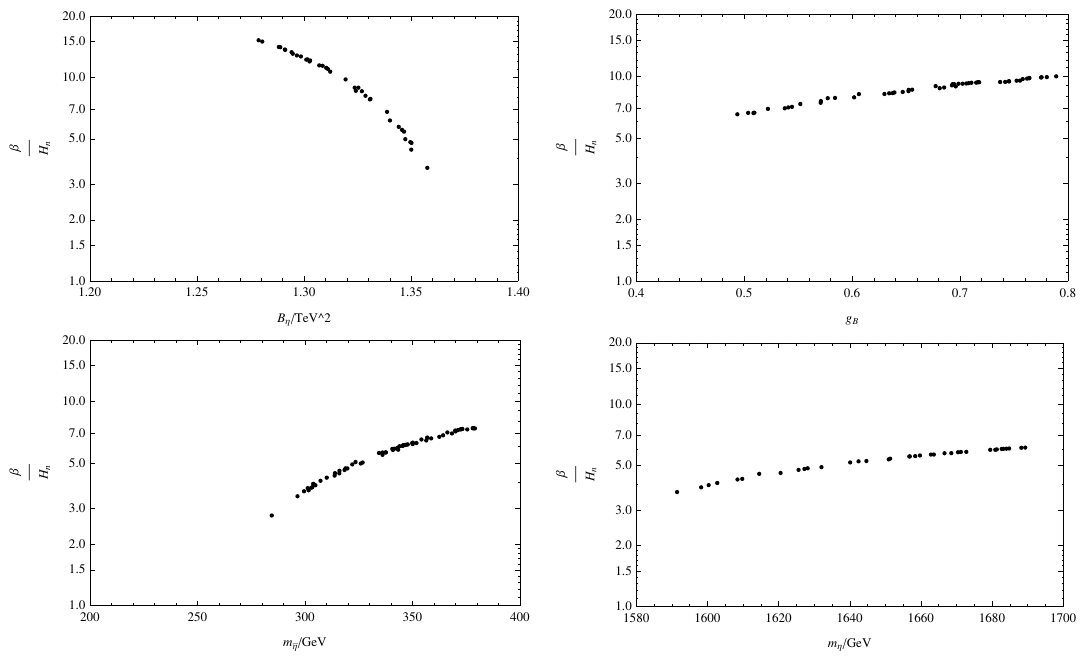
Figure 4 . The values of β/H n change with the parameters B η , g B , m η and m